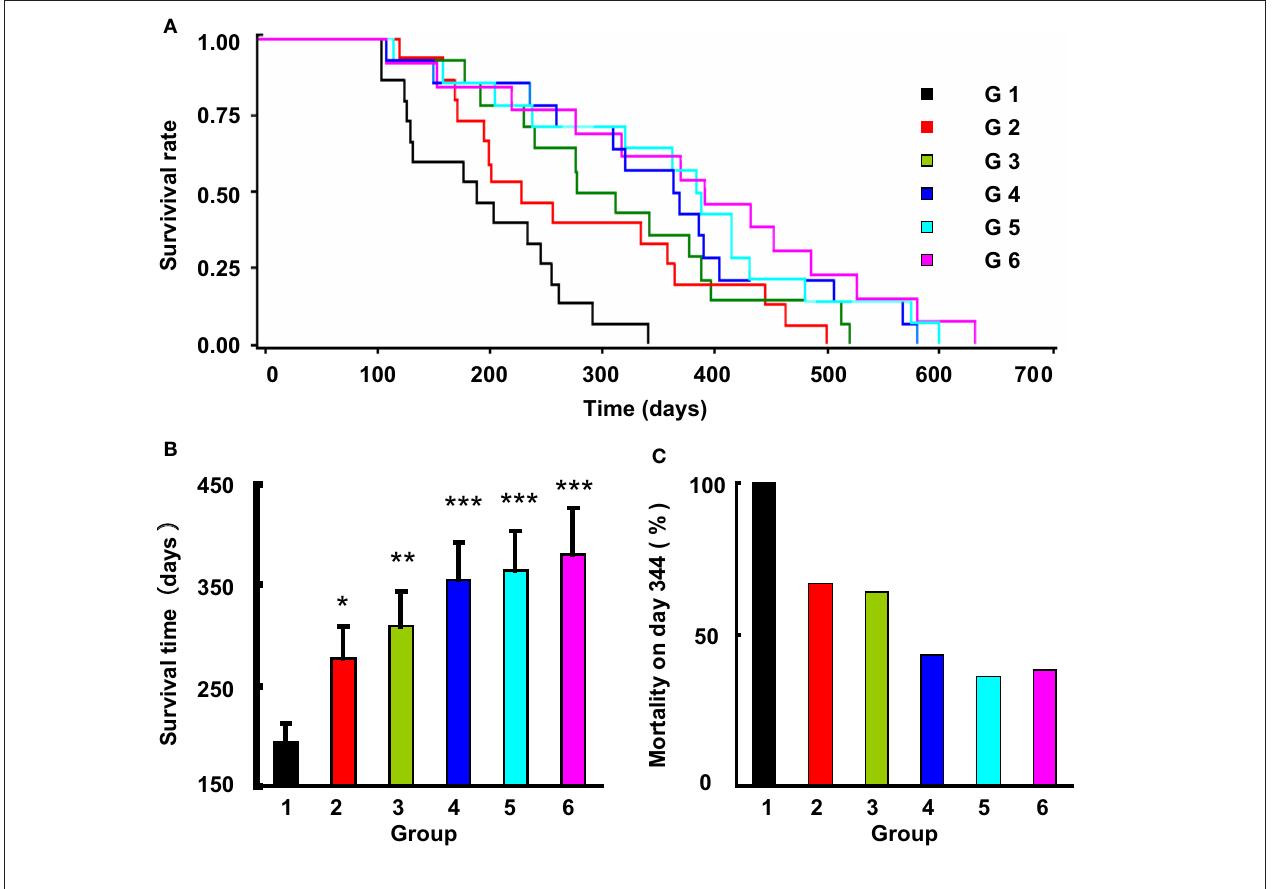
FiGure 3 | The effects of life-long treatment of ketanserin and amlodipine on the stroke death in 2K2C rats. (A) The survival rate in these six subgroups (G, group), doses referred to Table 1 , is expressed by Kaplan-Meier survival